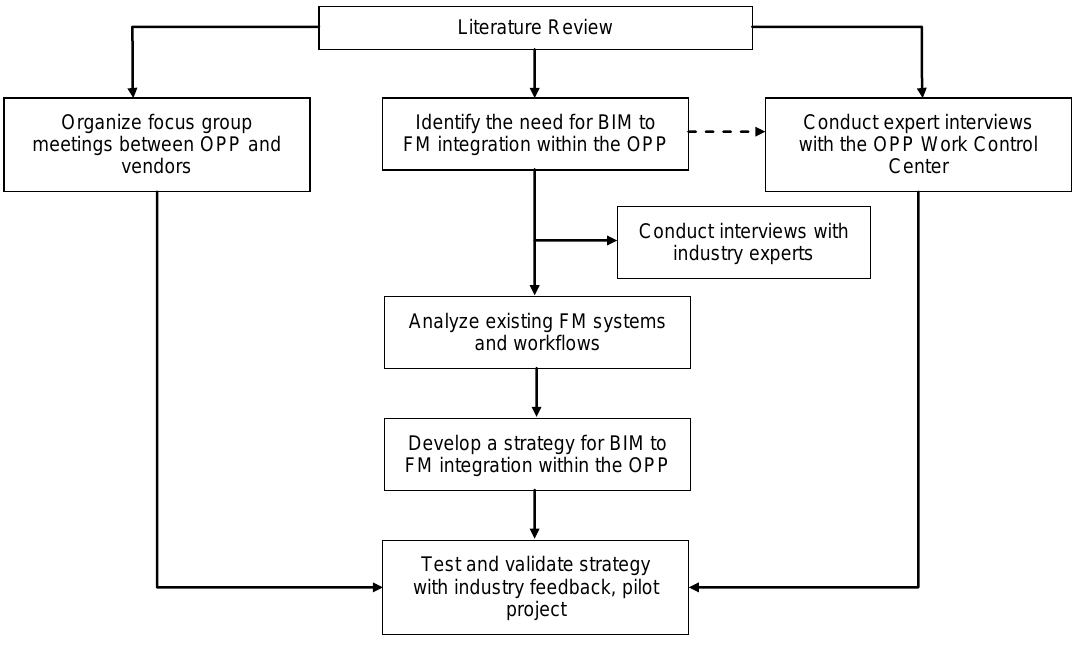
Figure 1 Research Methodology Workflow Process